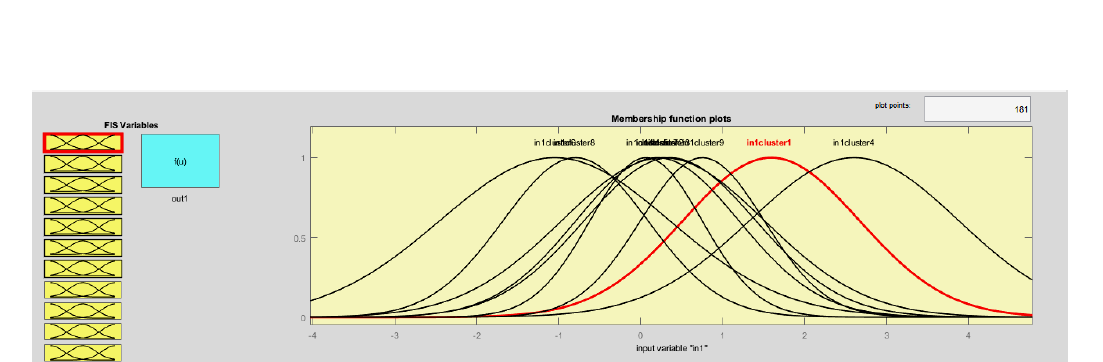
Figure 2. Membership function plot Value for cluster 1